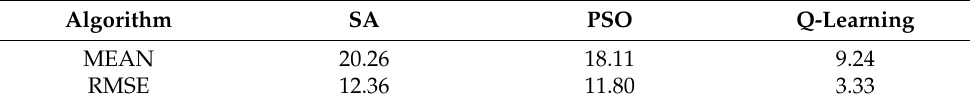
Table 6. Intelligent algorithm